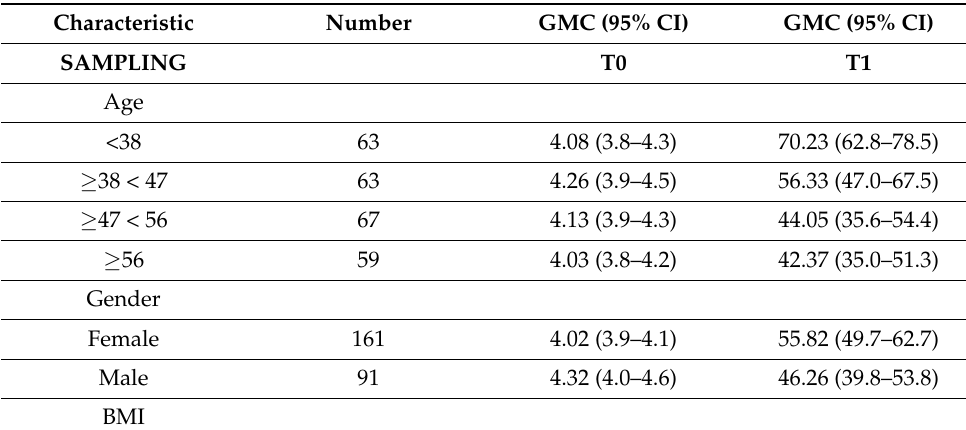
Figure 1. Levels of anti-SARS-CoV-2 spike IgG antibodies. Sera were analysed by LIAISON ® SARS-CoV-2 S1/S2 IgG test (Diasorin, Italy) as in methods. Positive (range 15–45 AU/mL) and negative controls (range <3.8–6.00 AU/mL) scored 31.6 AU/mL and <3.8 AU/mL, respectively. ( a ) pre-vaccine vs. vaccine vs. control group from previous infected HCW; ( b ) by gender (F: female, M: male); ( c ) by age classes; ( d ) by BMI classes. Serum was collected from the participant’s antibody 21 days after the priming dose. Antibody levels were expressed as log10 of concentration in Arbitrary Unit (AU). Age was categorised according to quartiles. Body mass index (BMI) classes were categorised according to Weir CB and Jan A [8]. Black dots represent outlier values. Table 1. Confidence intervals by age, gender and